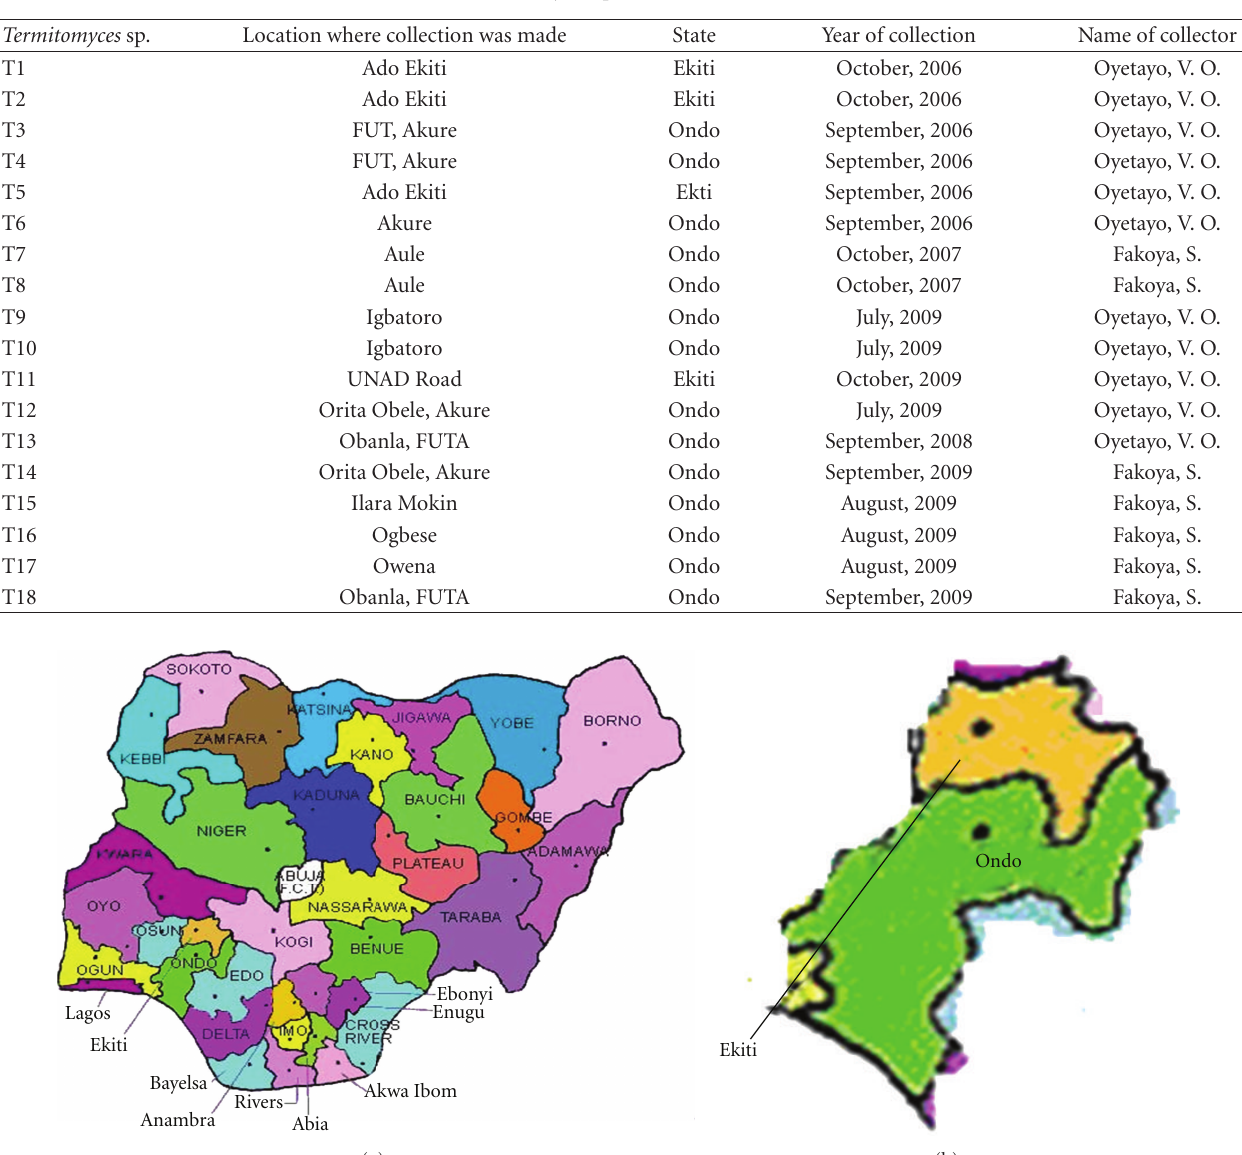
Table 1: Information on Termitomyces species collected from Ondo and Ekiti States. Termitomyces sp.